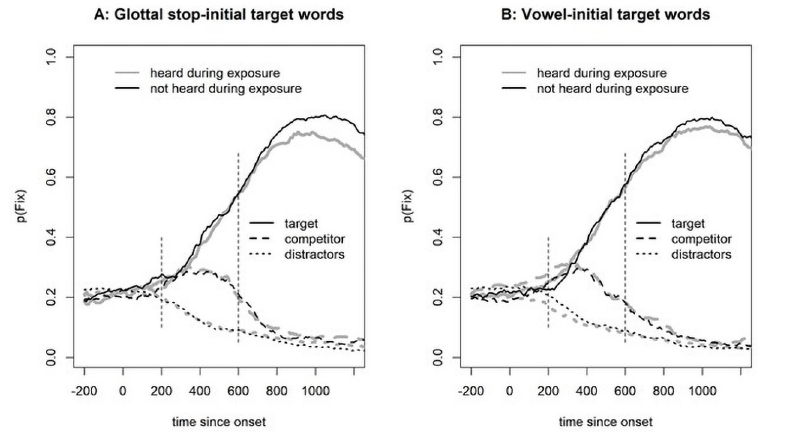
Fig 5. Fixation proportion in Experiment 2 relative to target word